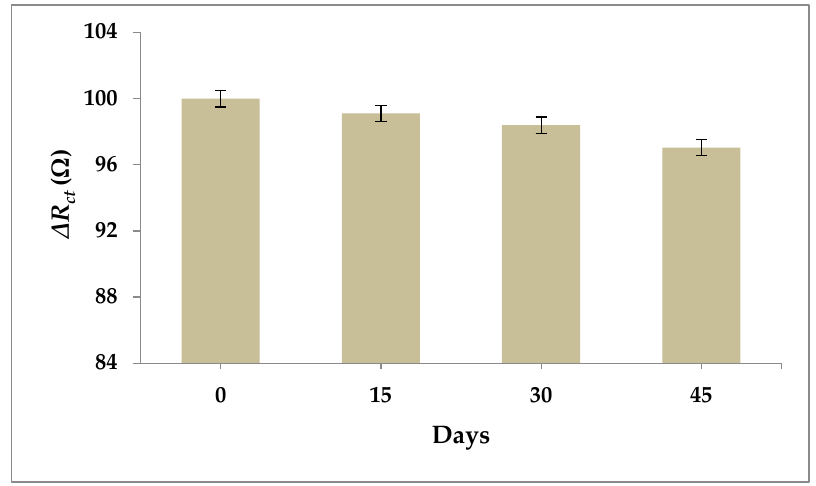
Figure 13. Stability analysis of aptasensor for (±)-3,4 Methylenedioxymethamphetamine (MDMA) detection. Table 3. Precision of repeatability determination via intra- and inter-batch analysis of developed aptasensor.